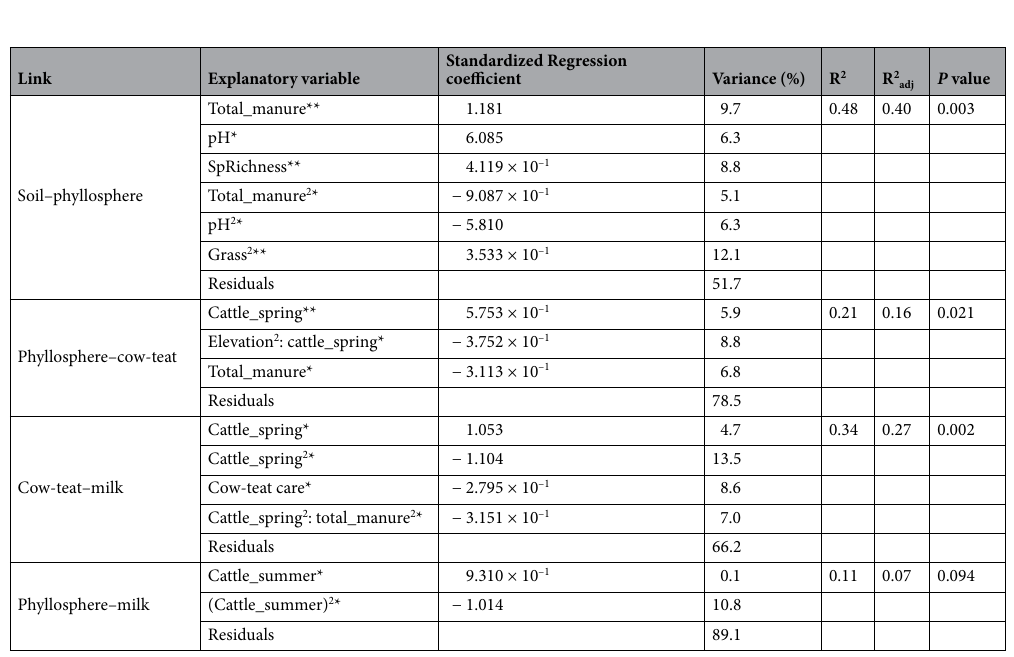
Table 3. Effects of environmental conditions on microbial transfers. R 2 , R 2 adj and P value refer to the whole model. The significance of the marginal effect of each variable is indicated by the following codes: *P < 0.05; **P < 0.01, ***P <